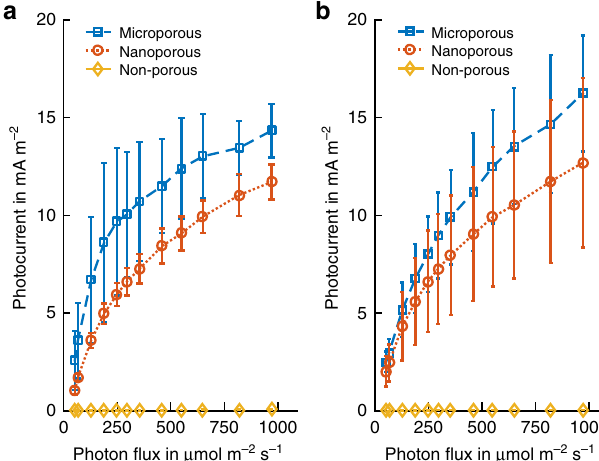
Fig. 6 Saturation behaviour. a Peak current generated by Synechocystis cells on the three anode types at different light levels. The values are averages of the peak minute after subtracting the dark current. b Nostoc bio fi lm maximum photocurrents as in ( a )